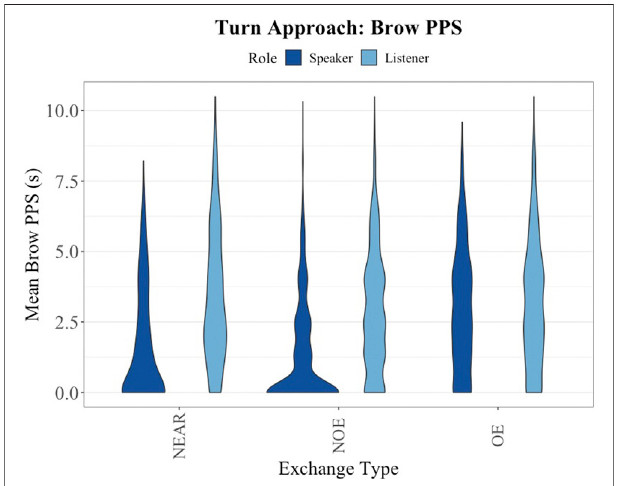
FIGURE 7 | Turn Approach Head PPS summary by exchange type and